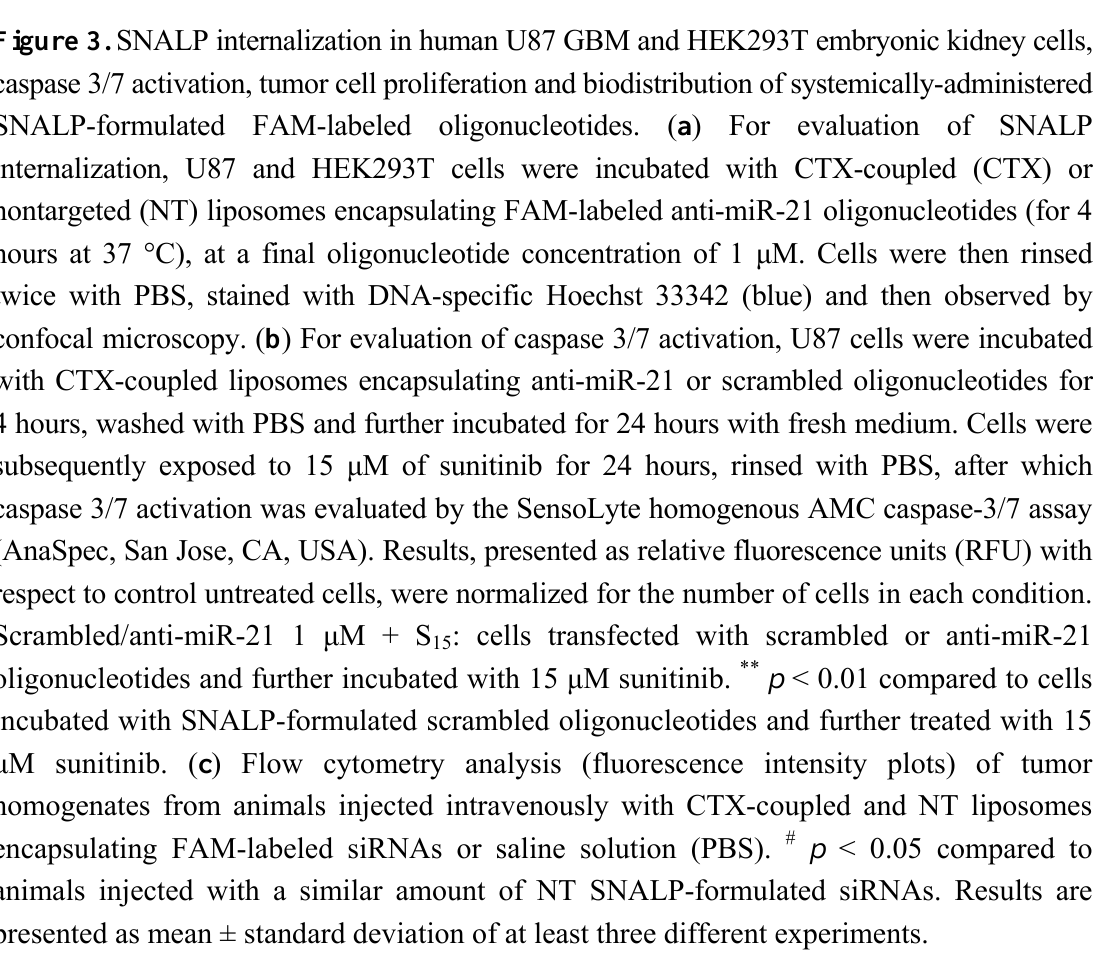
Figure 3. SNALP internalization in human U87 GBM and HEK293T embryonic kidney cells, caspase 3/7 activation, tumor cell proliferation and biodistribution of systemically-administered SNALP-formulated FAM-labeled oligonucleotides. ( a ) For evaluation of